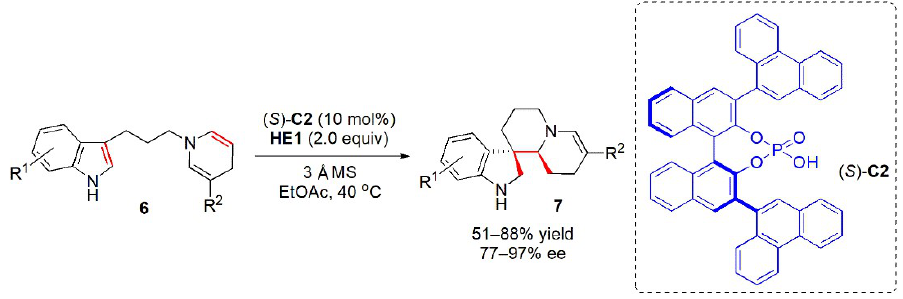
Figure 5. Catalytic enantioselective synthesis of spiroindolines [46].